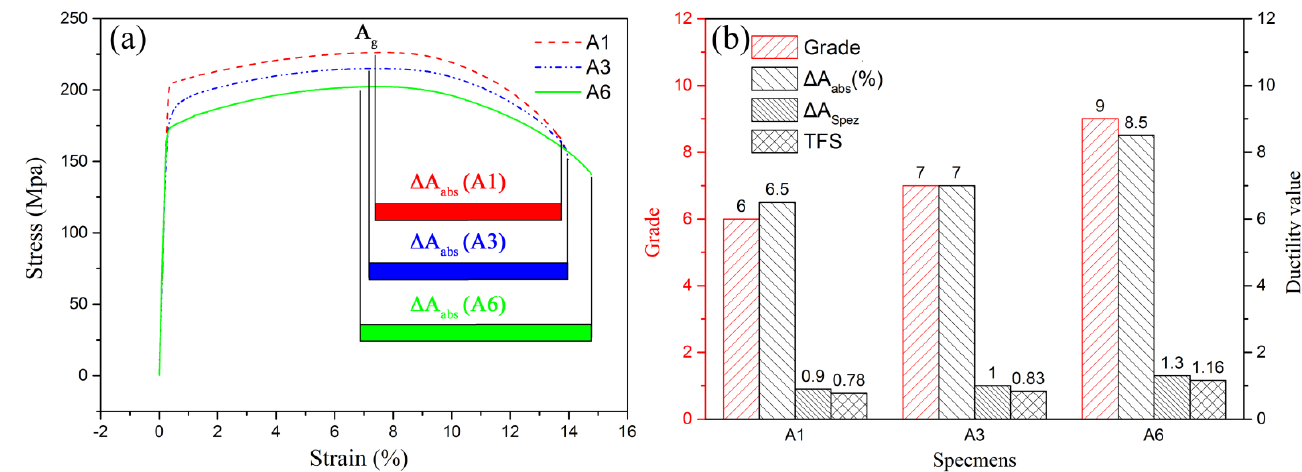
Figure 3. Information about ( a ) stress–strain curve in tensile test and ( b ) relationship between crushing grade and ductility indices.